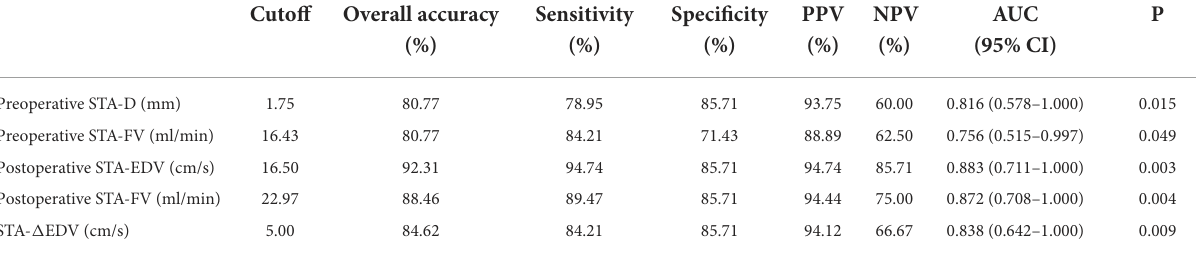
TABLE 6 The cutoff values and AUC for the collateral development after STA-MCA